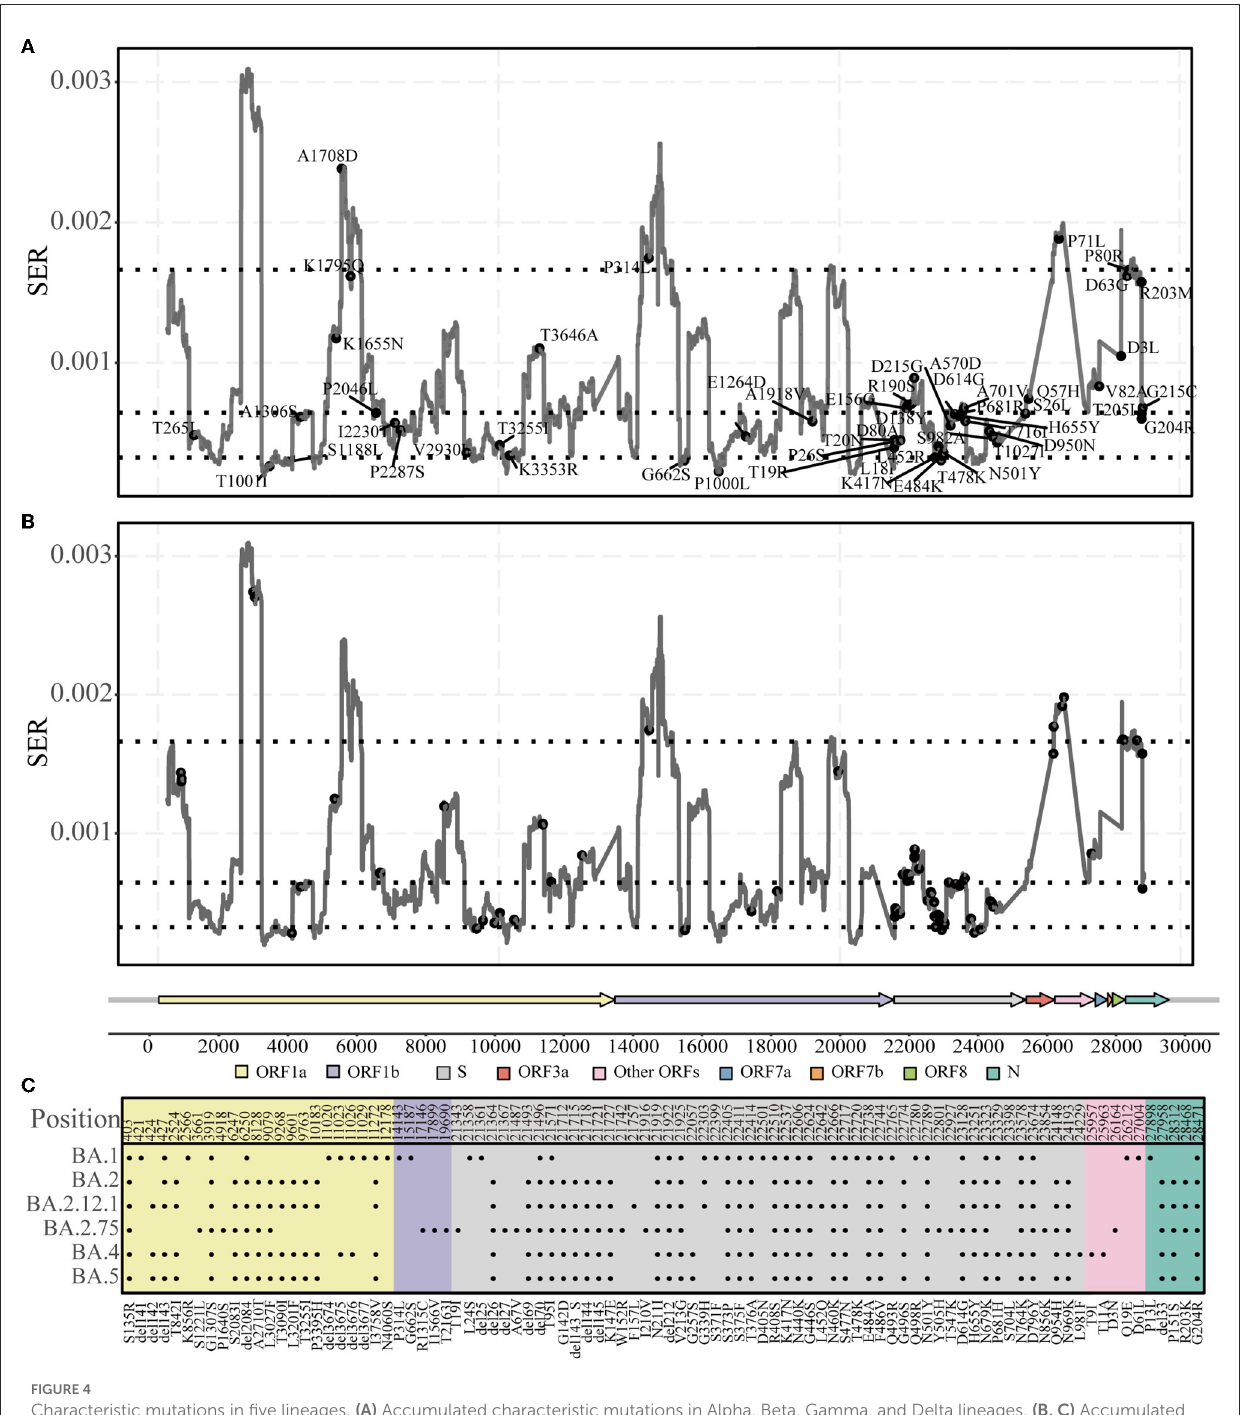
FIGURE4 Characteristic mutations in five lineages. (A) Accumulated characteristic mutations in Alpha, Beta, Gamma, and Delta lineages. (B, C) Accumulated characteristic mutations in the Omicron lineage and their specific positions.